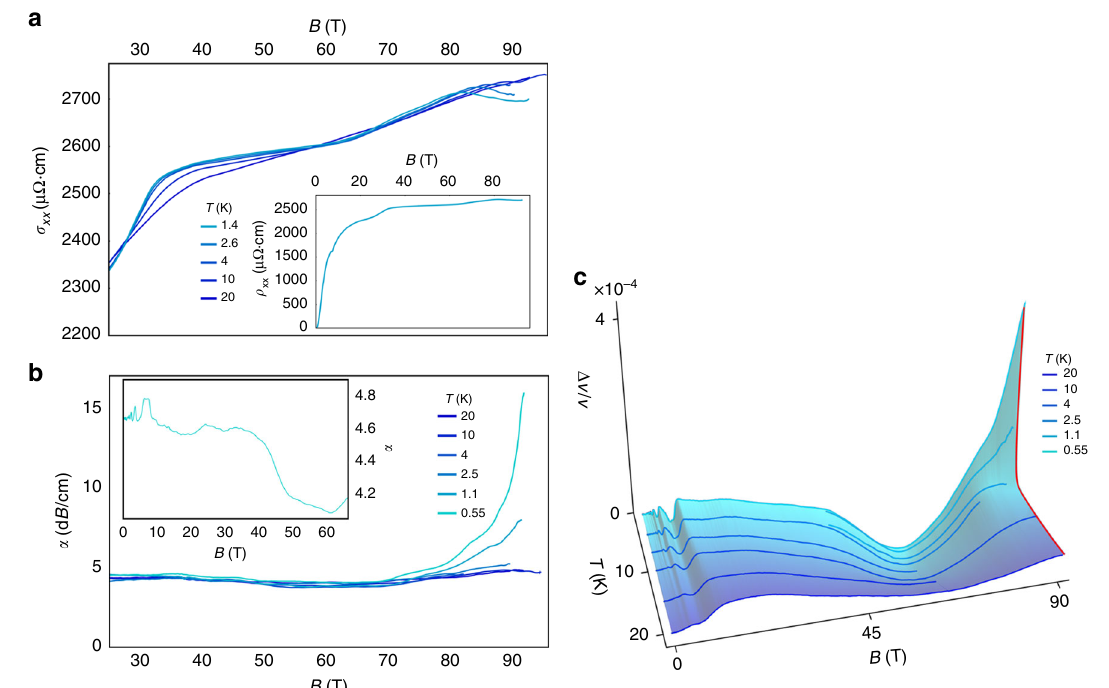
Fig. 4 Phase transition in the quantum limit of TaAs. a Resistivity for J ?ð B jj c Þ , showing a kink near 80 T at low temperature. b The ultrasonic attenuation at 315 MHz for k jj B jj c , where k is the propagation wavevector of the longitudinal (compressional) sound, and with data from 0 to 65 T shown in the inset. c Change in the speed of sound for the same con fi guration as the attenuation shown in ( b ). Data from two different experiments — one from 0 to 65 T and one from 45 to 95 T — are combined in this plot. Above 2.5 K the sound velocity fl attens out above 80 T and the attenuation is only weakly fi eld dependent. Below 2.5 K, however, both the sound velocity and the ultrasonic attenuation increase rapidly with fi eld. The red line is an interpolation of the data, highlighting the abruptness of the transition as a function of